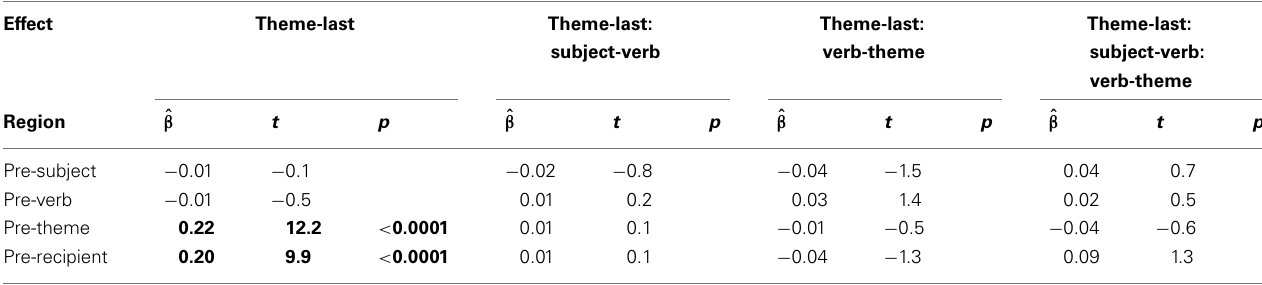
TableA2 | Interactions between post-verbal constituent order and phonological overlap on speech rate by sentence region.